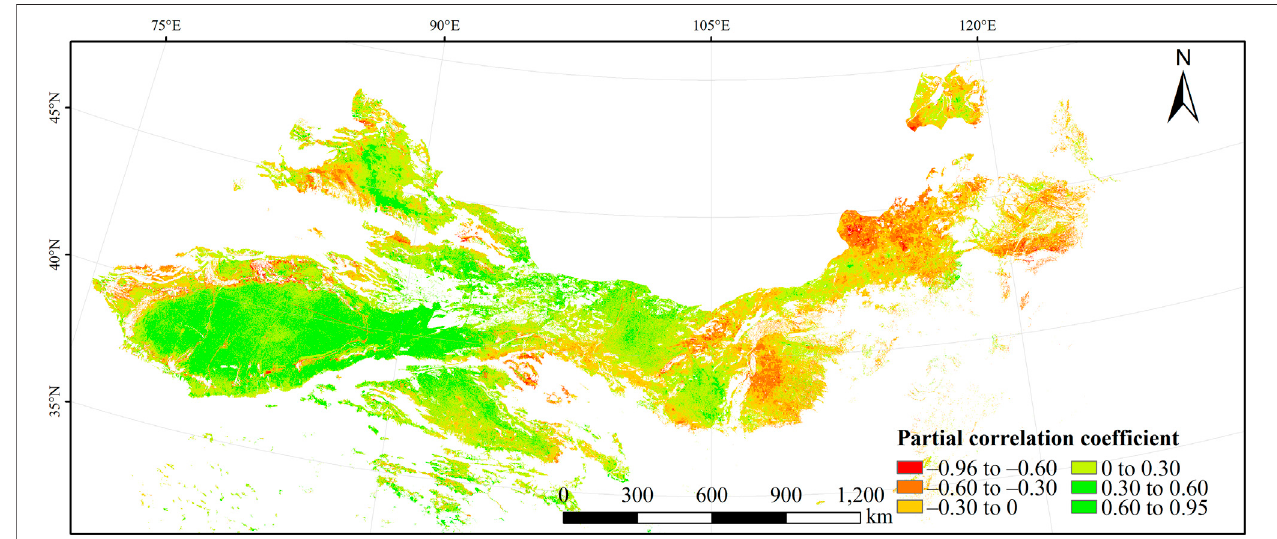
FIGURE7| Spatial distribution ofpartialcorrelationsbetweenthemulti-yearmeannormalized-differencevegetationindex (NDVI) from1998to2015andthemean annual temperature for the same period in the desert area of northern China.